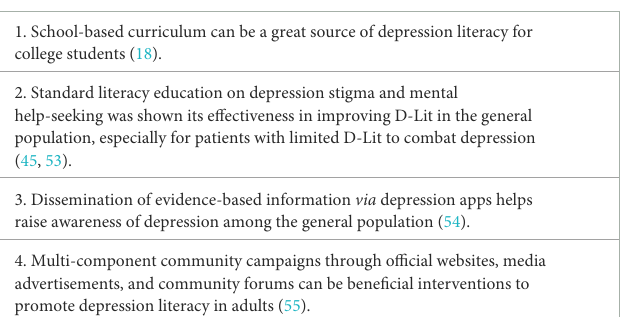
TABLE 4 Suggestions for strengthening public depression literacy and awareness of depressive